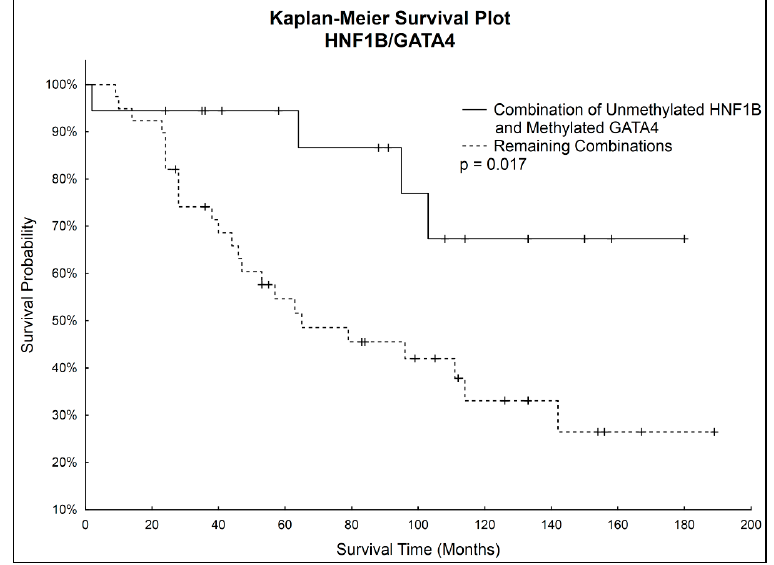
Figure 4. Survival probability of patients with simultaneously unmethylated HNF1B and Figure methylated GATA4 .